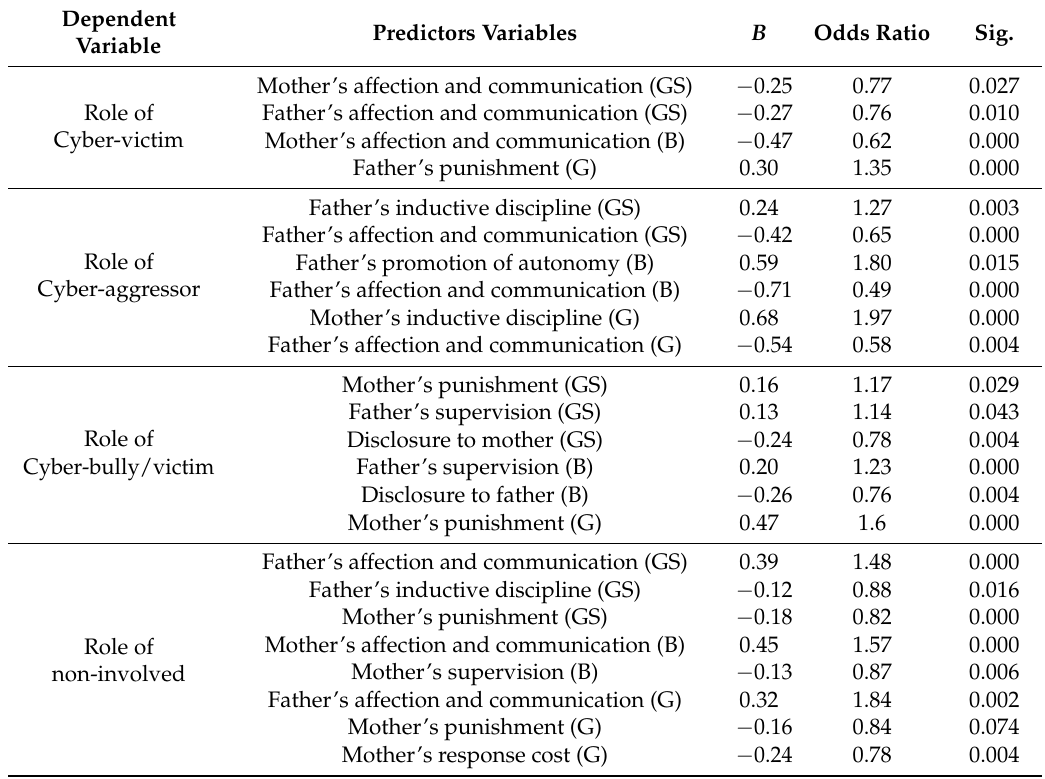
Table 6. Variables included in the regression equation for the different roles of